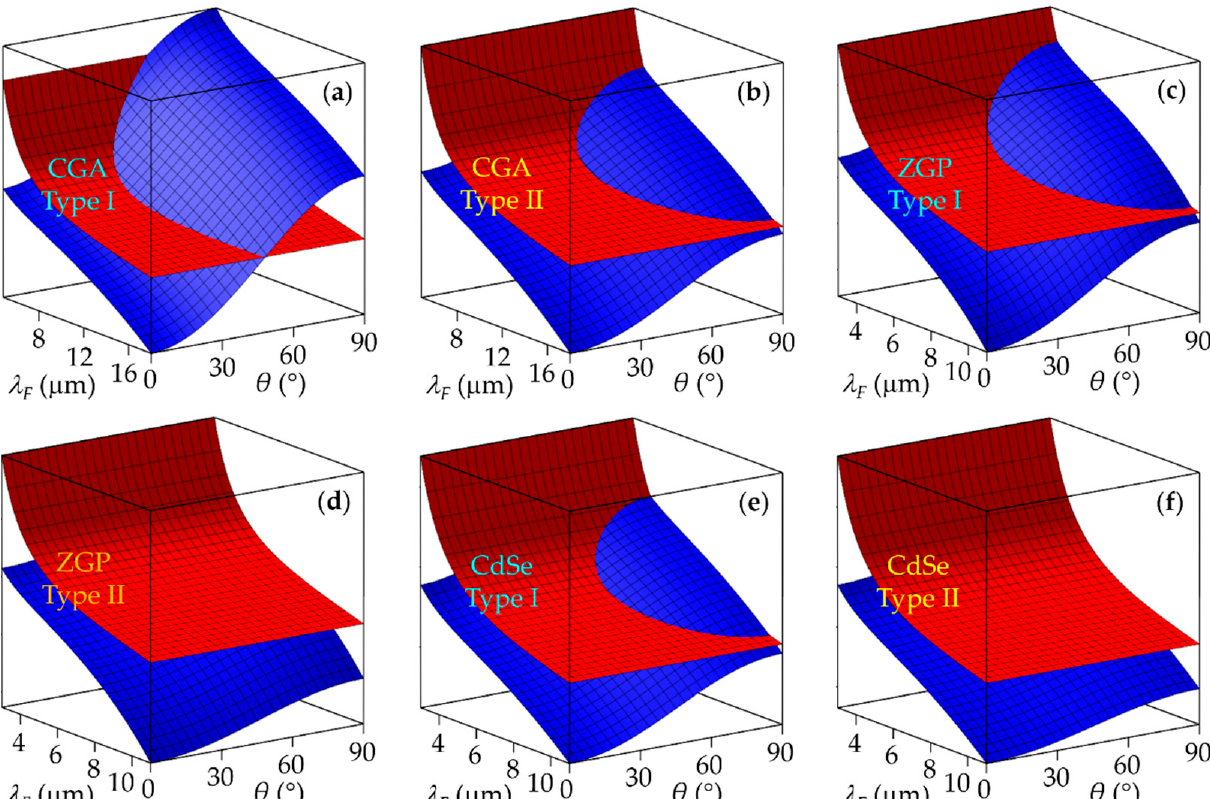
Figure 3. BPM properties of chalcopyrite semiconductors and defect chalcopyrite exhibiting positive uniaxial birefringence: ( a ) Type I and ( b ) Type II in CGA; ( c ) Type I and ( d ) Type II in ZGP; and ( e ) Type I and ( f ) Type II in CdSe. The red and blue surfaces represent n o ( λ F /2) and n e ( λ F , θ ) (for Type I) or 2 n o ( λ F /2) and n o ( λ F ) + n e ( λ F , θ ) (for Type II).